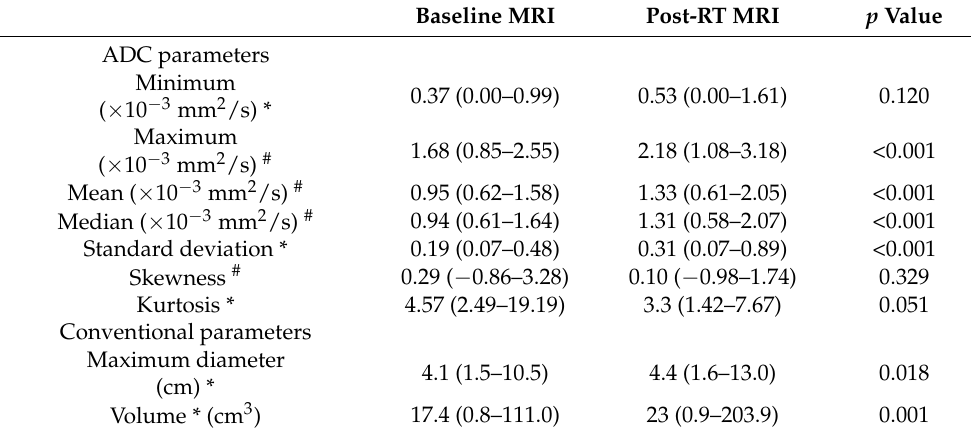
Table 2. MRI parameters before and after RT.